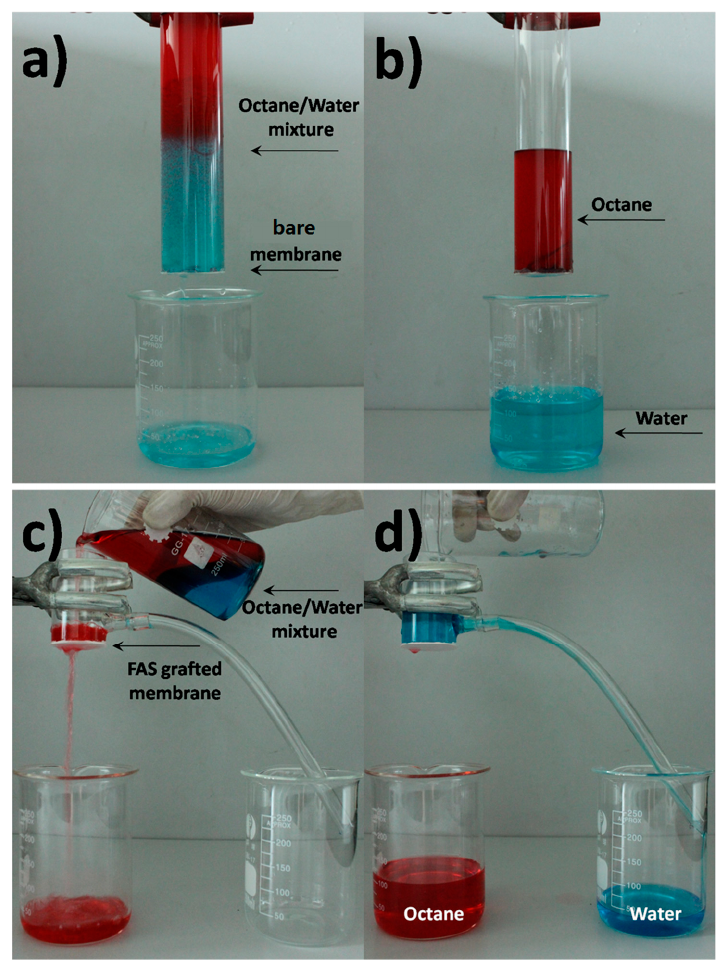
Figure 11. Oil/water separation equipment. ( a ) Octane/water mixture (30/70 v / v ) above a porous alumina membrane and water was poured into the beaker. ( b ) Water selectively permeated through the bare membrane, while the octane was repelled and remained in the upper glass tube. ( c ) Separation of octane/water mixture (70/30 v / v ) using the FAS-grafted membrane; octane easily passed through the membrane and flowed into a beaker. ( d ) Water was repelled by the FAS-grafted membrane and flowed into another beaker.